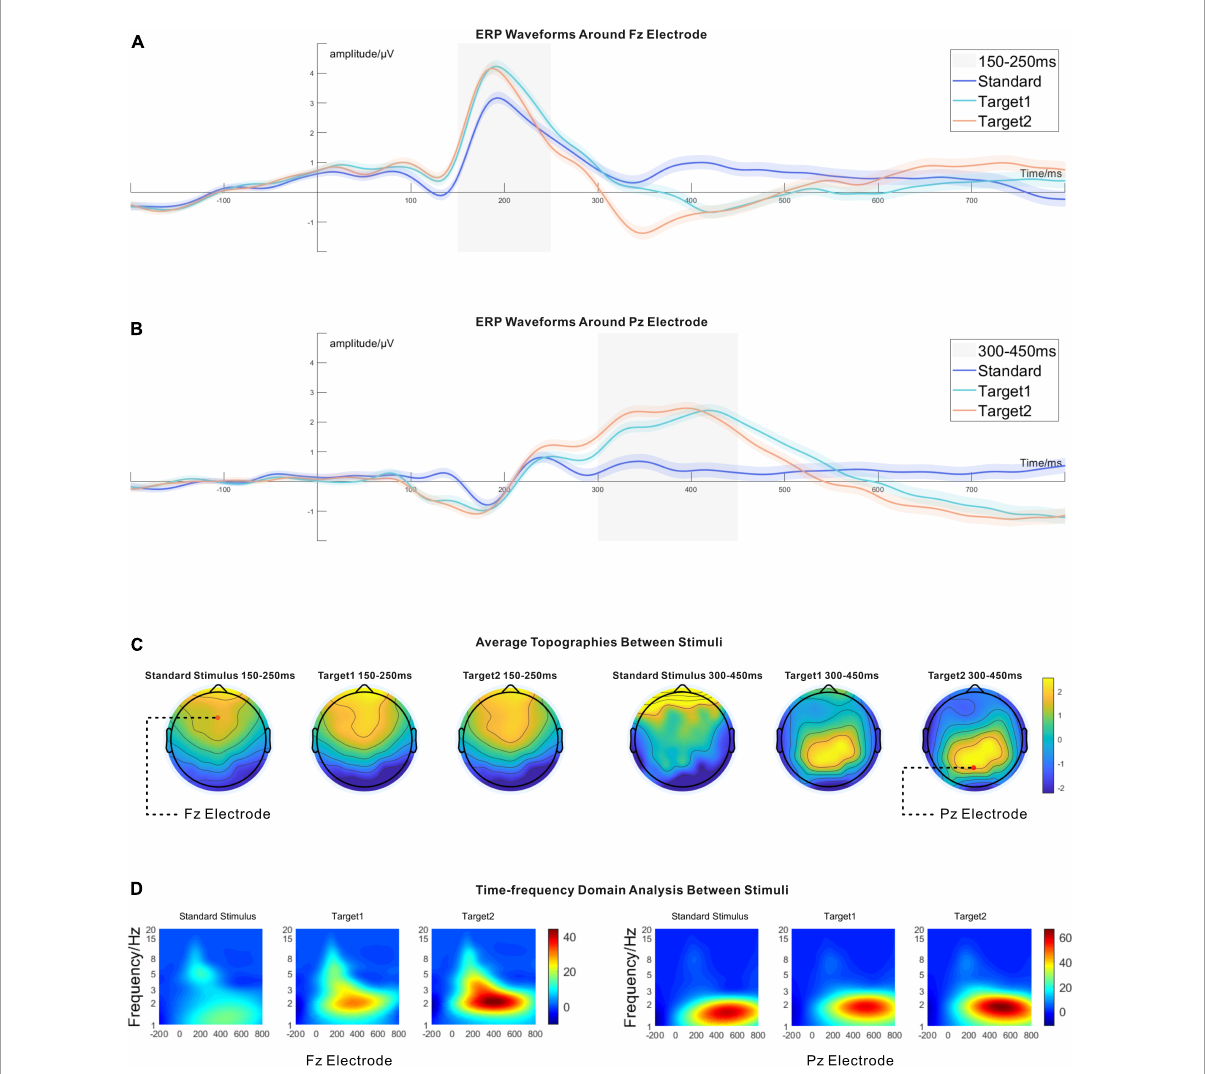
FIGURE5 (A) The time domain analysis around the Fz electrode. There was no difference between Target 1 and Target 2 around the time window of 150–250 ms. The amplitudes of Target 1 and Target 2 were higher than the standard stimulus around 150–250 ms. The 95% CIs are shown